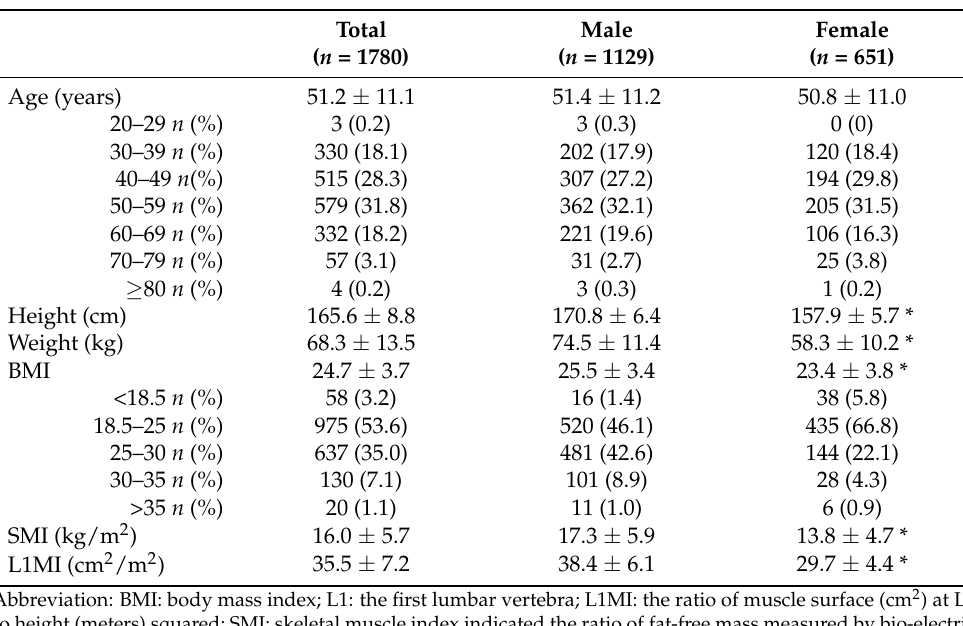
Table 1. The characteristics of the total population and sex-specific subgroups.